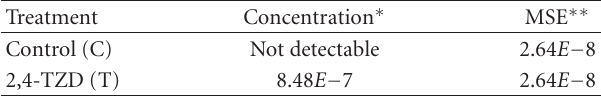
Table 3: Comparisons of chromatography residues in liver